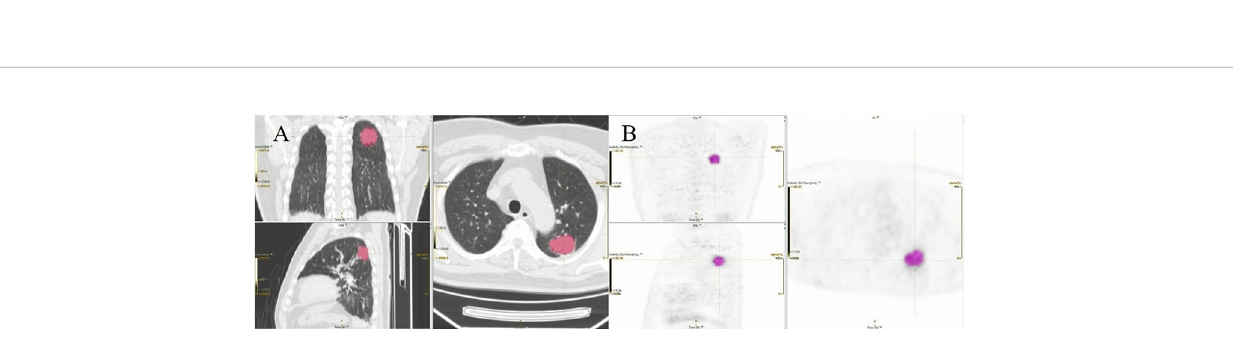
FIGURE 5 | Classi fi ers ’ performance on predicting the expression status of PD-L1 based on three models (radiomics, clinics, and the combined model). Classi fi ers ’ performance on predicting 1% level of PD-L1 (A) . Classi fi ers ’ performance on predicting 50% level of PD-L1 (B) .